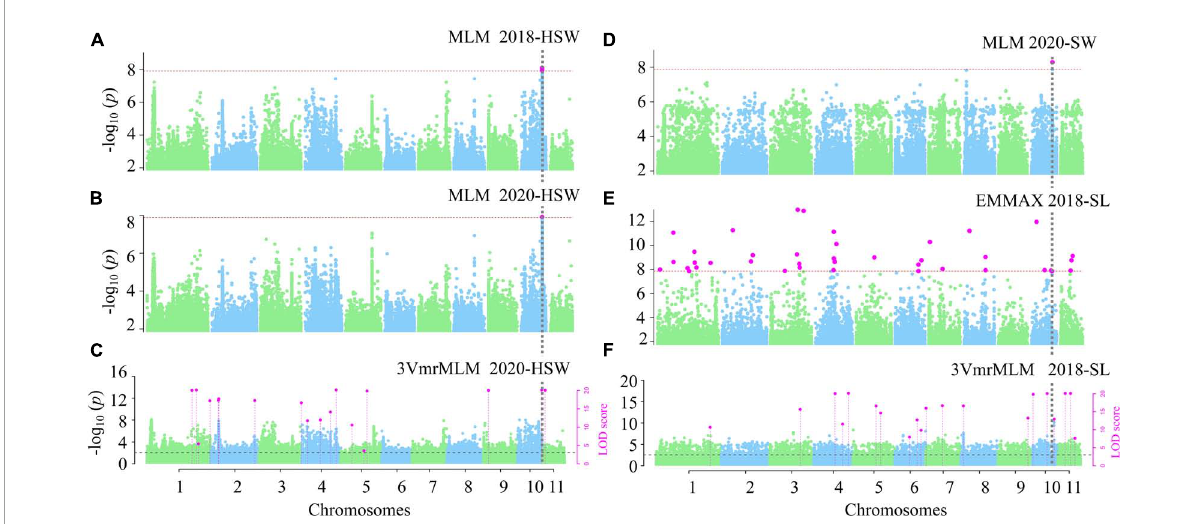
FIGURE2 Manhattan plots for the GWAS for seed-yield-related traits. GWAS for HSW (A–C) , SW (D) and SL (E,F) . Significant QTN in phenotypic GWAS was set at P -value ≤ 0.05/m = 1.39e-08 ( m = 3607508), ≤ 2.77e-09 for CMLM and EMMAX (A,B,D,E) ; and LOD ≥ 3.0 for the 3VmrMLM as the significant QTN, and all the critical values were marked by horizontal lines, Y -axis on the left side reports –log10 P -values of SNP, while Y -axis on the right side reports LOD scores, and LOD scores are shown in points with straight